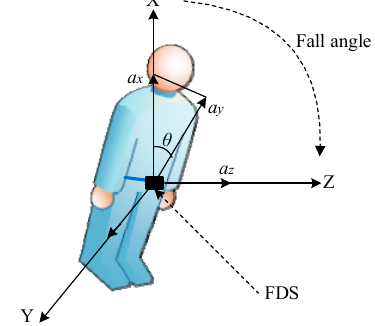
Figure 12. Geodetic coordinates of the elderly.